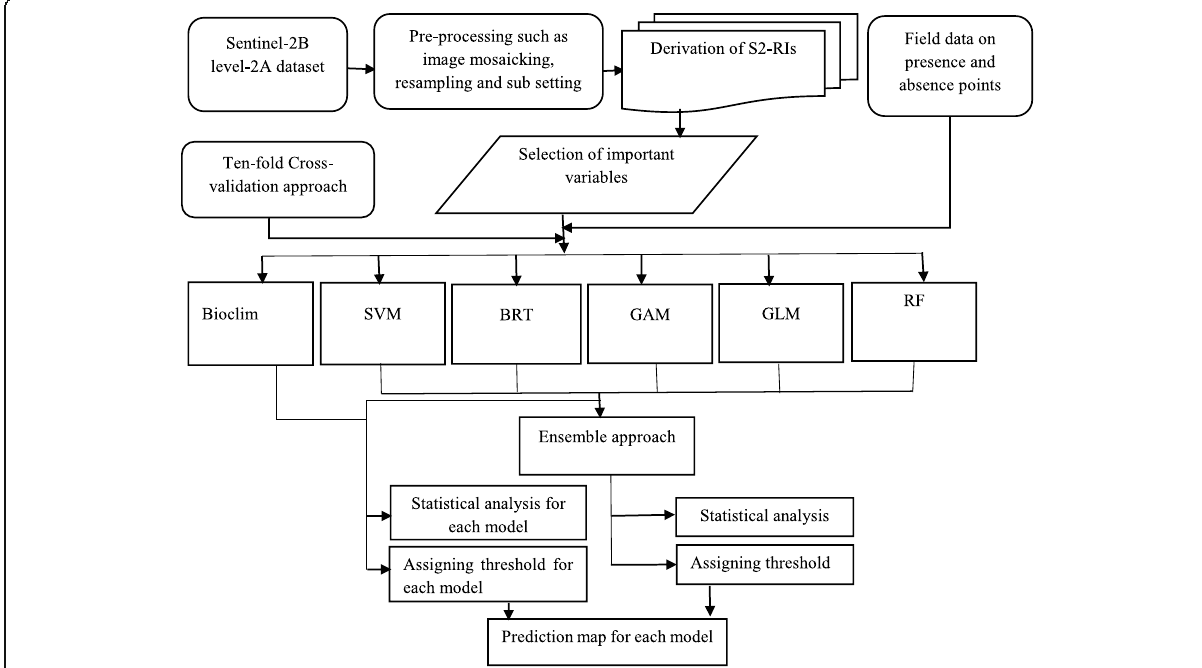
Fig. 2 Methodological flowchart showing the prediction of the current distribution of invasive Prosopis distribution using six individual and one ensemble models from selected predictor variables of Sentinel-2B level-2A